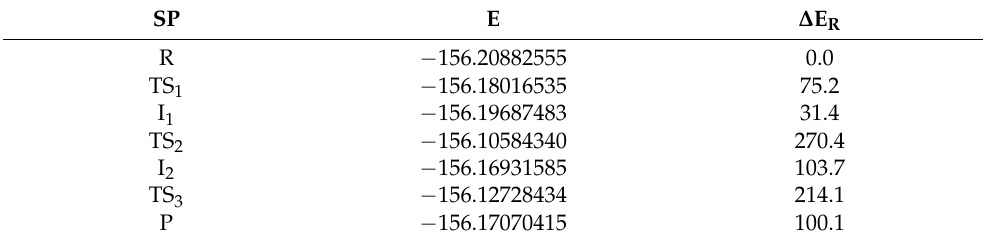
Table 1. Energy (a.u.) and energy differences ∆ E R = E(SP) − E(R) (kJ · mol − 1 ) for the stationary points (SP) of the 3D → 2D isomerization in hexaborane(12). R = Reactant, SP = Stationary